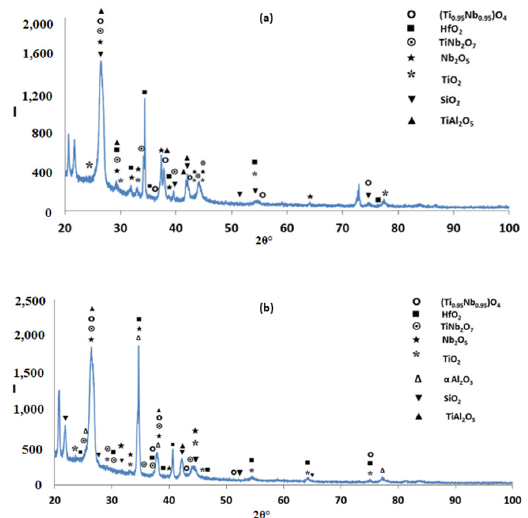
Figure 10. Glancing angle X ray diffractograms (θ = 5°) of the alloy Nb 1.7 Si 2.4 Ti 2.4 Al 3 Hf 0.5 after isothermal oxidation ( a ) at 800 °C; ( b ) at 1200 °C.